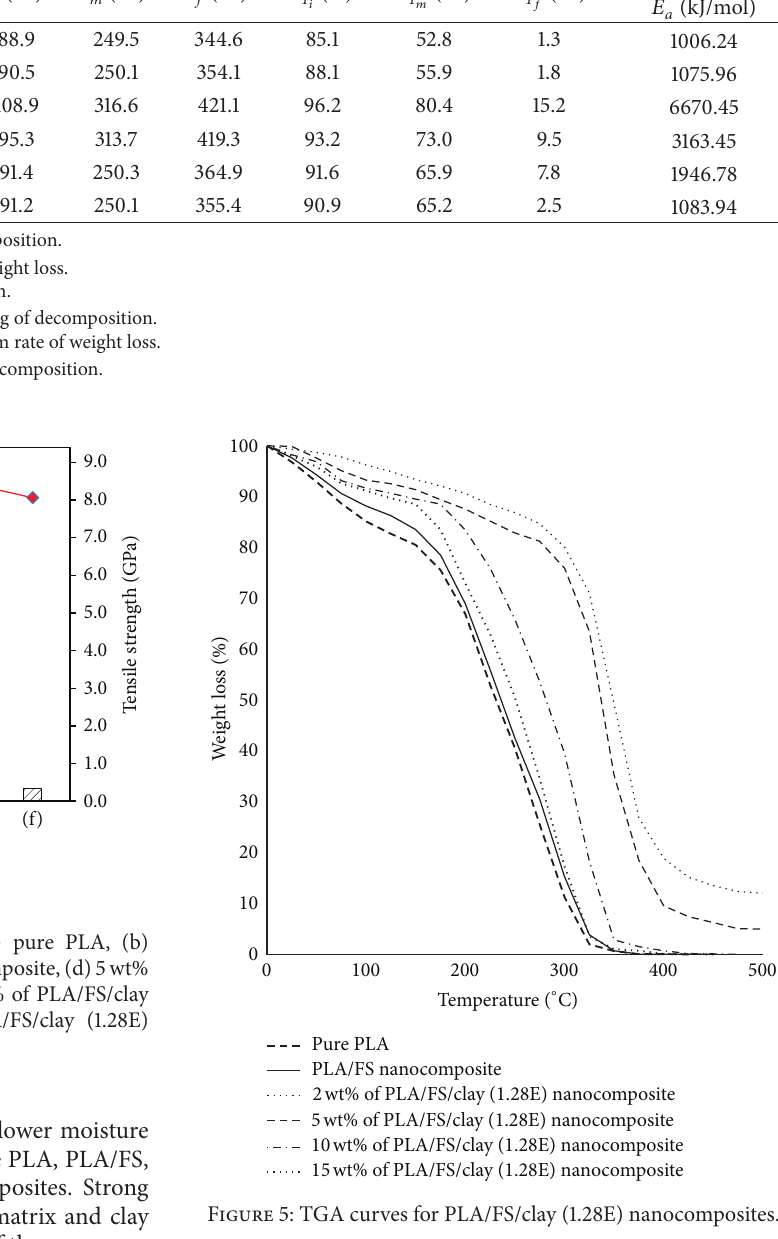
Table 2: Activation energy of PLA/FS/clay (1.28E) nanocomposites determined by using Arrhenius equation. Samples